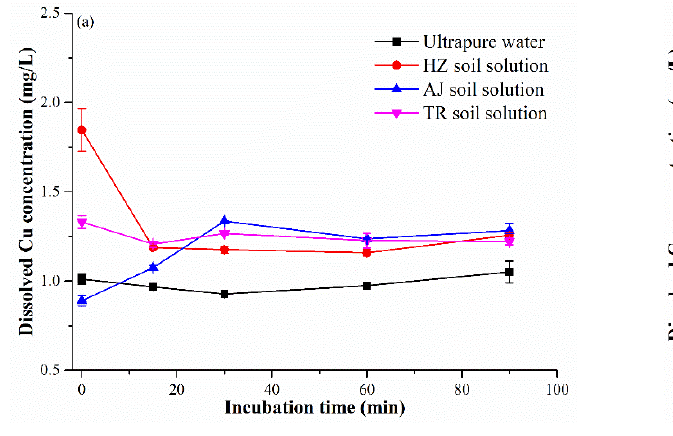
Figure S2: The aggregation of NPF, AI and NR in the AJ soil solution as a function of time. (a) NPF. (b) AI. (c) NR; Figure S3: The aggregation of NPF, AI and NR in the HZ soil solution as a function of time. (a) NPF. (b) AI. (c) NR. Table S1: Basic physiochemical properties of soil used in this study.